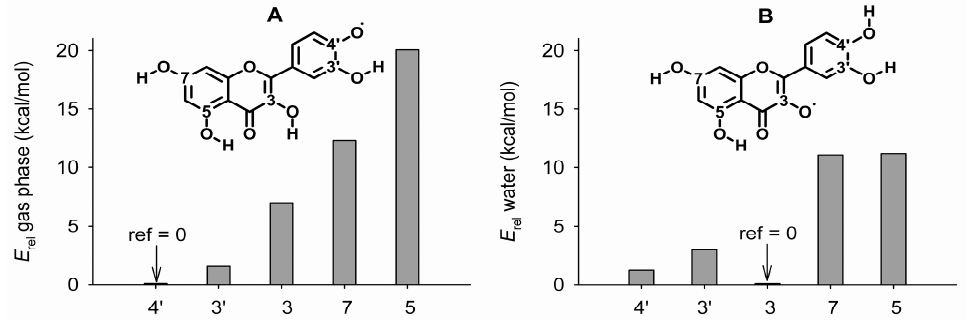
Figure 2. Relative stability of the neutral radicals obtained by H-atom abstraction from quercetin, calculated in the gas phase ( A ) and in water ( B ), determined from the relative energy ( E rel ) with reference to the most stable species (ref = 0). Numbers on the x -axis indicate the position of the radical.